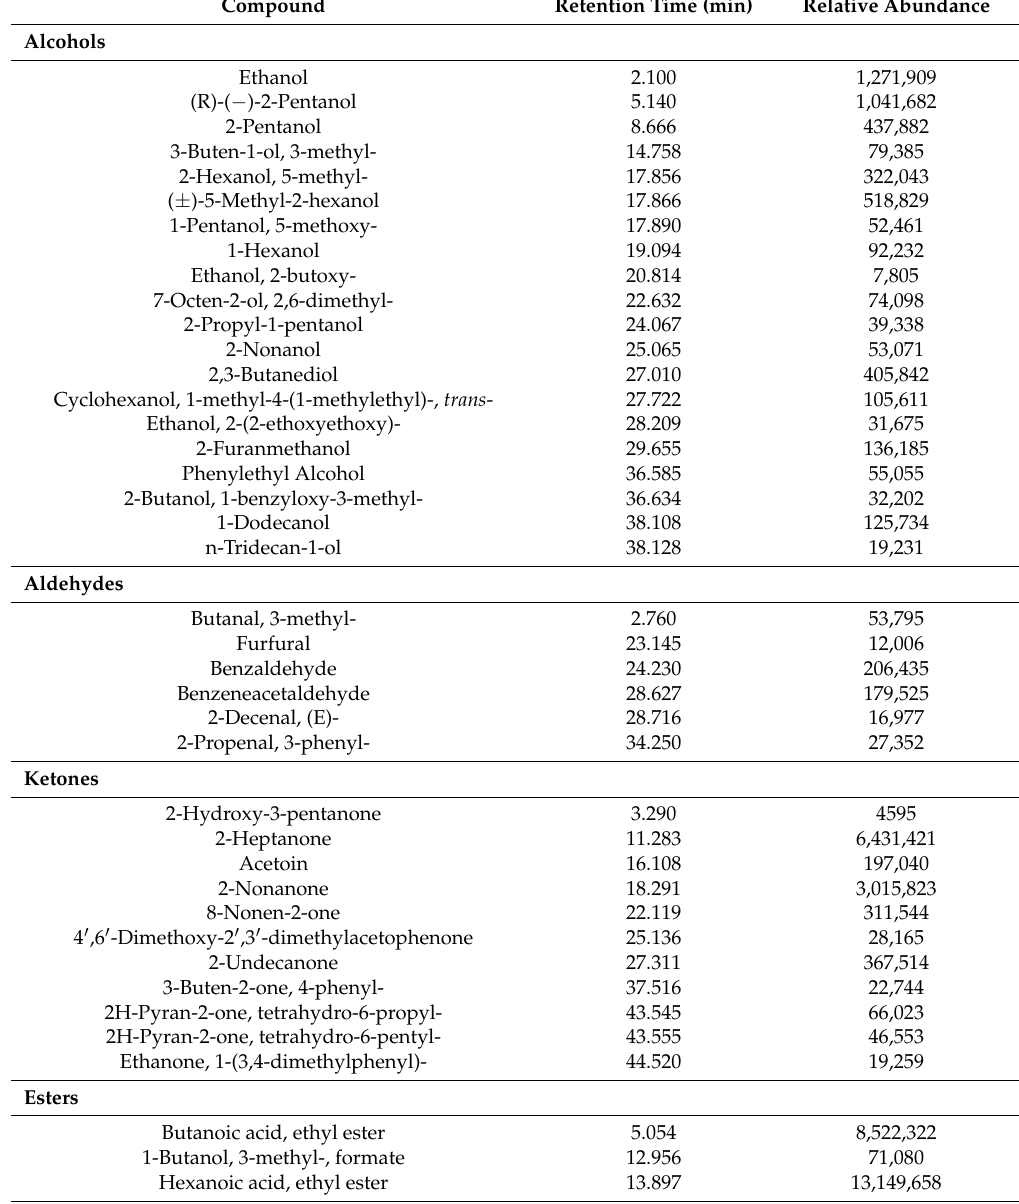
Table 3. List of volatile organic compounds (VOCs) identified in Parmigiano Reggiano cheese by SPME-GC-MS